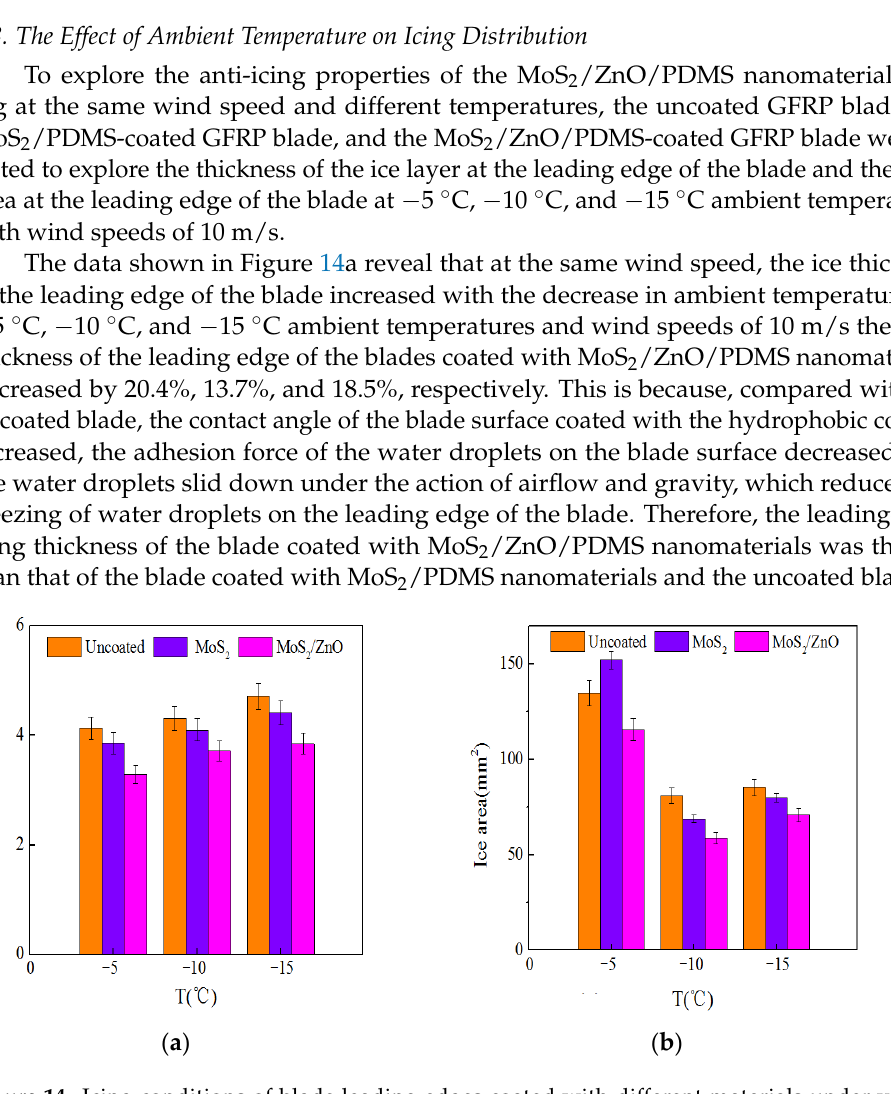
Figure 13. Icing profiles of blade surface in different environments.